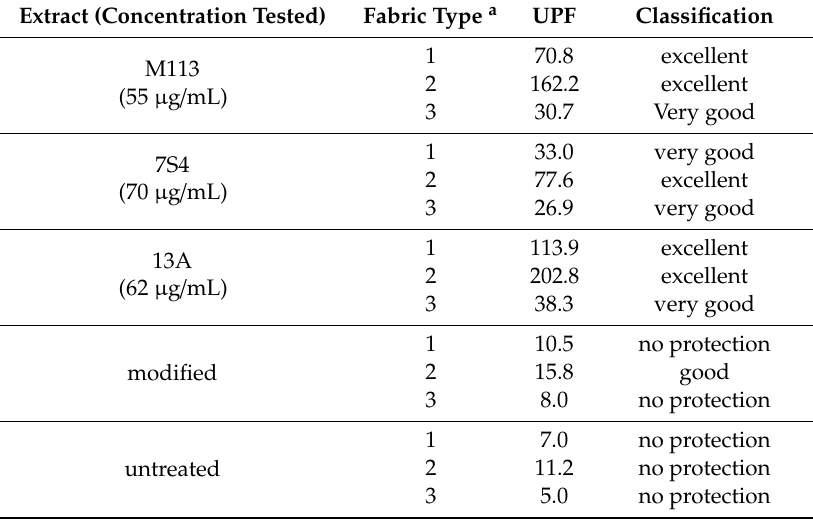
Table 4. UV protective properties of di ff erent textile fabrics treated with selected fungal extracts. Extract (Concentration Tested) Fabric Type